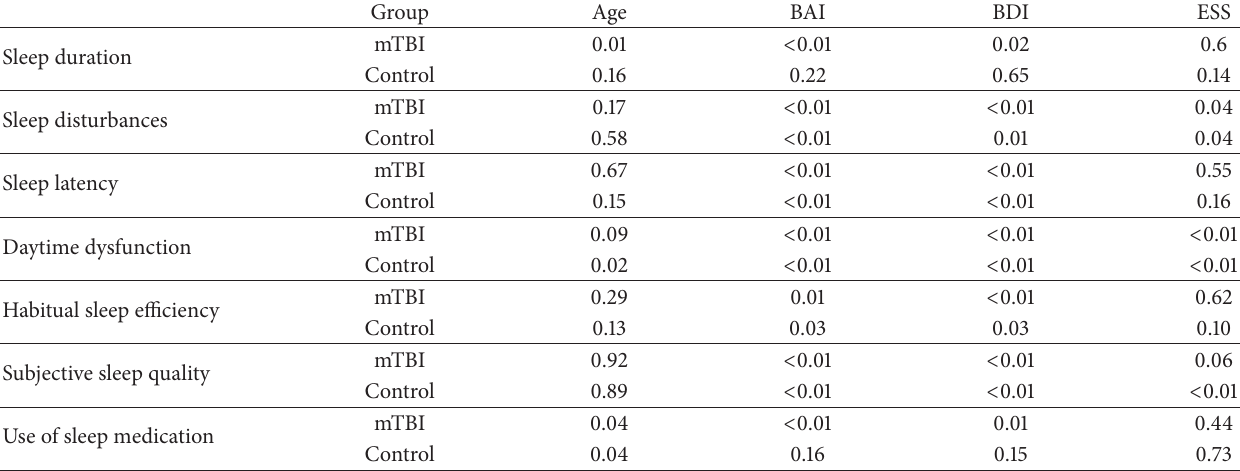
Table 3: 𝑃 value of Spearman’s correlation among the PSQI subscores and age, BDI, BAI, and ESS